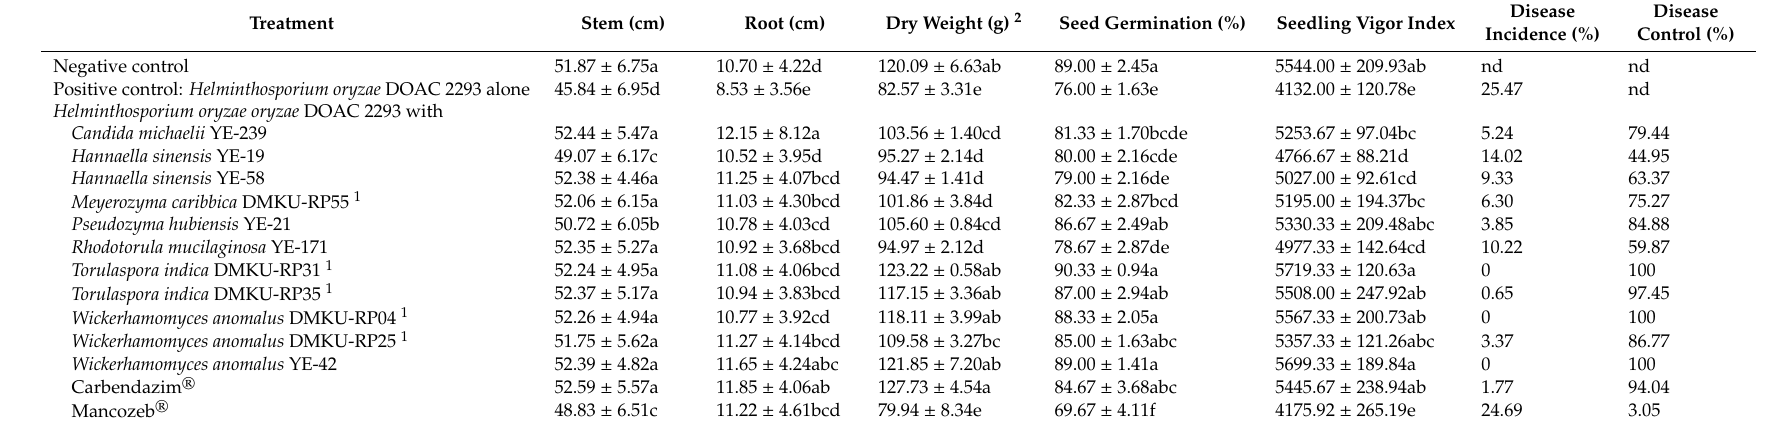
Table 5. Control of rice seedling rot disease caused by Helminthosporium oryzae DOAC 2293 by antagonistic yeasts and chemical fungicides.